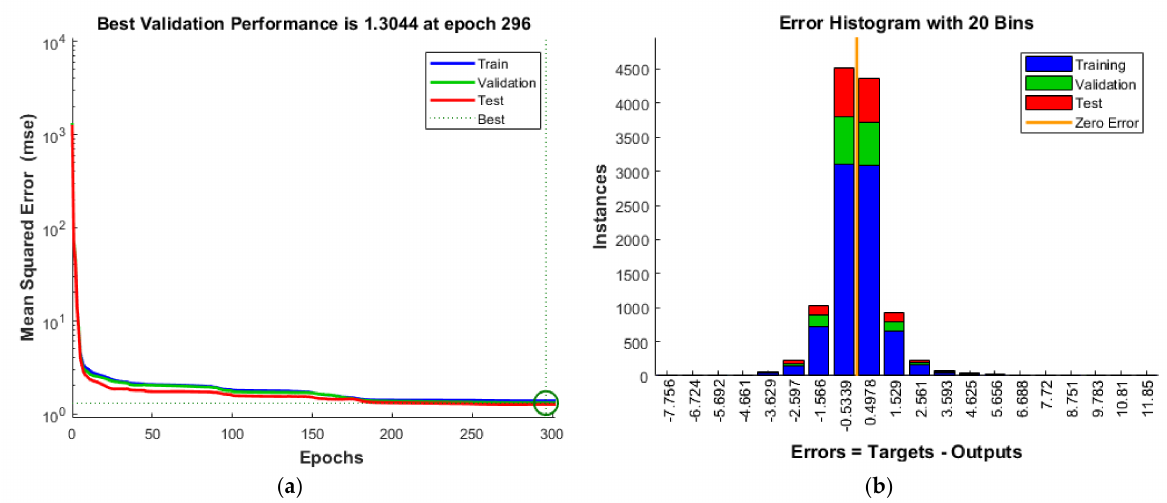
Figure 6. Schematic representation of ( a ) ANN training performance and ( b ) histograms of error values of the developed predictive